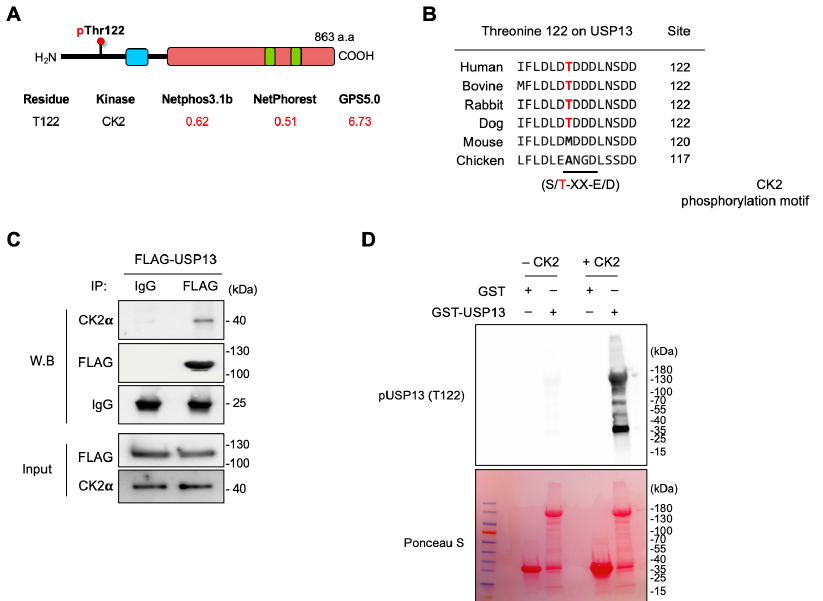
Figure 4. CK2 interacts and phosphorylates USP13 at Thr122 in vitro. ( A ) Prediction of putative kinase against Thr122 was performed by using NetPhos server 3.1, NetPhorest, and GPS5.0. Three software predicted CK2 as a kinase for Thr122 with a high score (red). ( B ) Alignment of USP13 homologous sequences showing the CK2 phosphorylation consensus site. The amino acid at the location corresponding to Thr122 of human USP13 is marked in bold. Amino acid numbering is according to the USP13 sequence. ( C ) USP13 interacts with CK2 α . The protein–protein interaction of USP13 and CK2 α was confirmed by immunoprecipitation. ( D ) CK2 phosphorylates USP13 in vitro. Bacterially expressed and purified USP13 proteins were incubated with active CK2 α in the presence of ATP. Reaction products were separated by SPS-PAGE, and an anti-pT122 antibody was used to detect phosphorylated USP13. The amount of GST and GST-USP13 protein was shown by Ponceau S red staining.